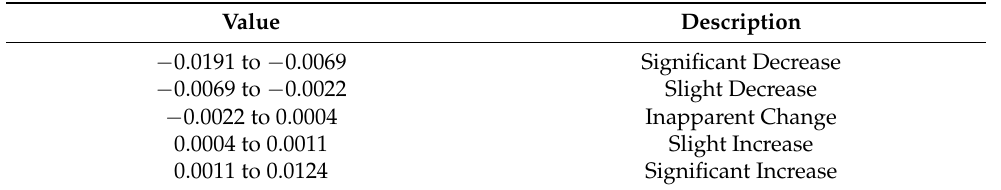
Figure 6. ( a ) Change trend of the ES value in the HRB. ( b ) Proportion of area associated with each trend in Jiangsu (JS), Anhui (AH), Shandong (SD), and Henan (HN) provinces. ( c ) Proportion of area associated with each trend in the HRB. Table 4. Classification of the ES variation